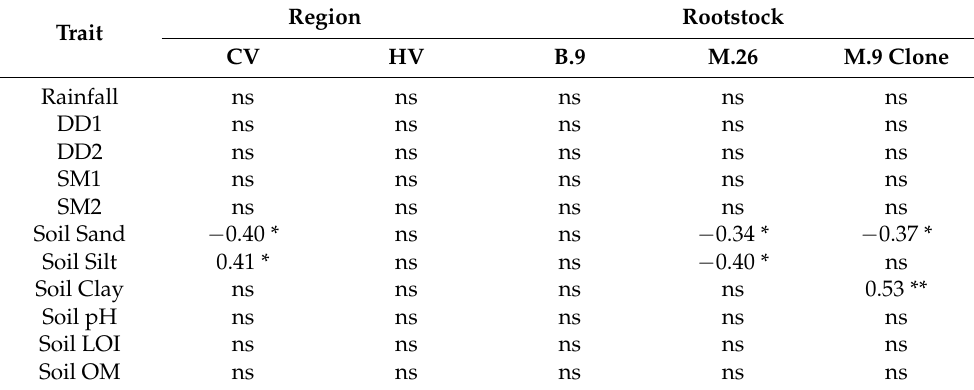
Table 3. Multivariate analysis for bitter pit (%) in ‘Honeycrisp’ apples stored at 2.2 ◦ C for 120 days against all weather and soil traits for each rootstock category and region with all three years combined